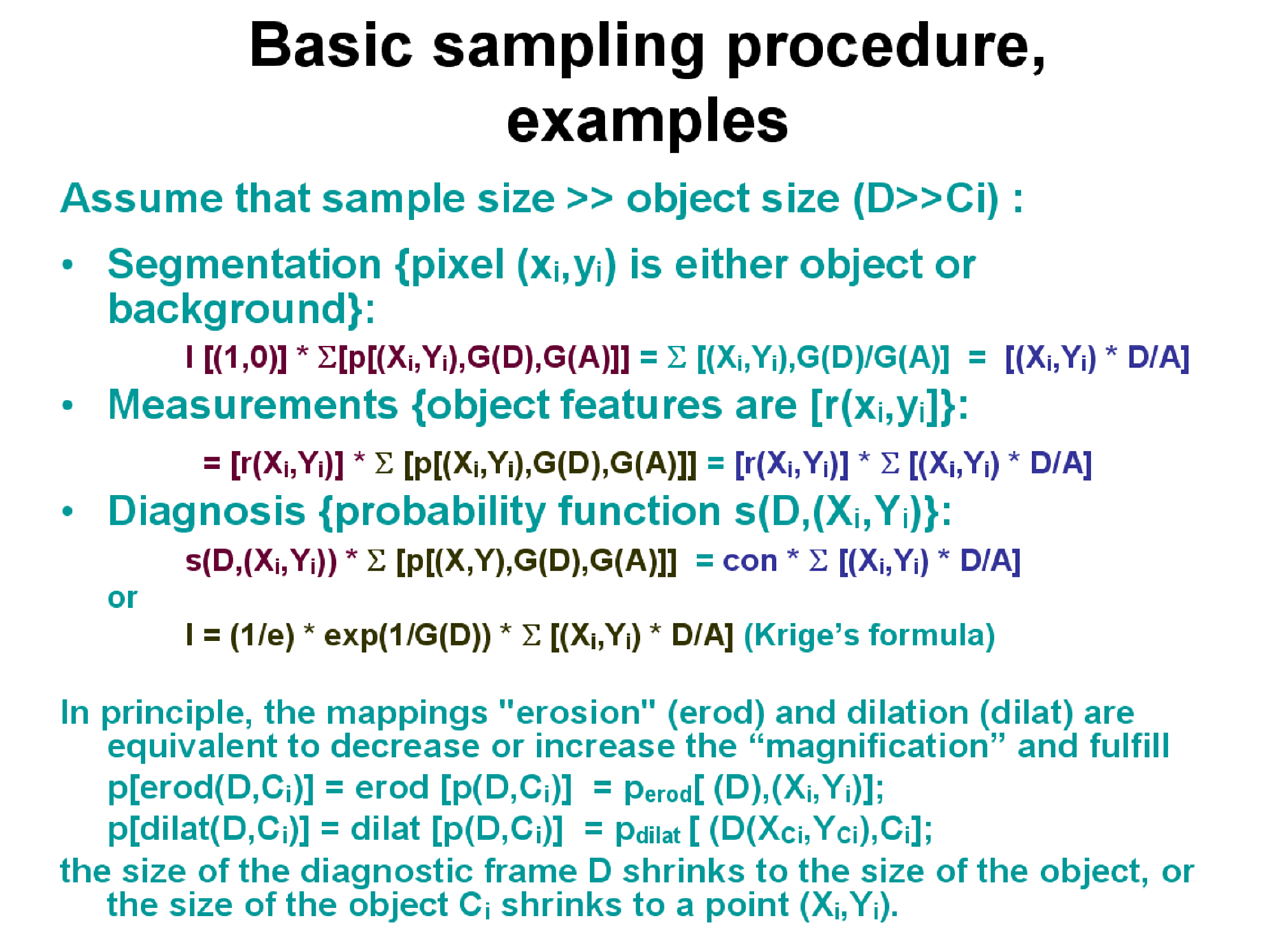
Examples of sampling procedures in segmentation and diagnosis classification